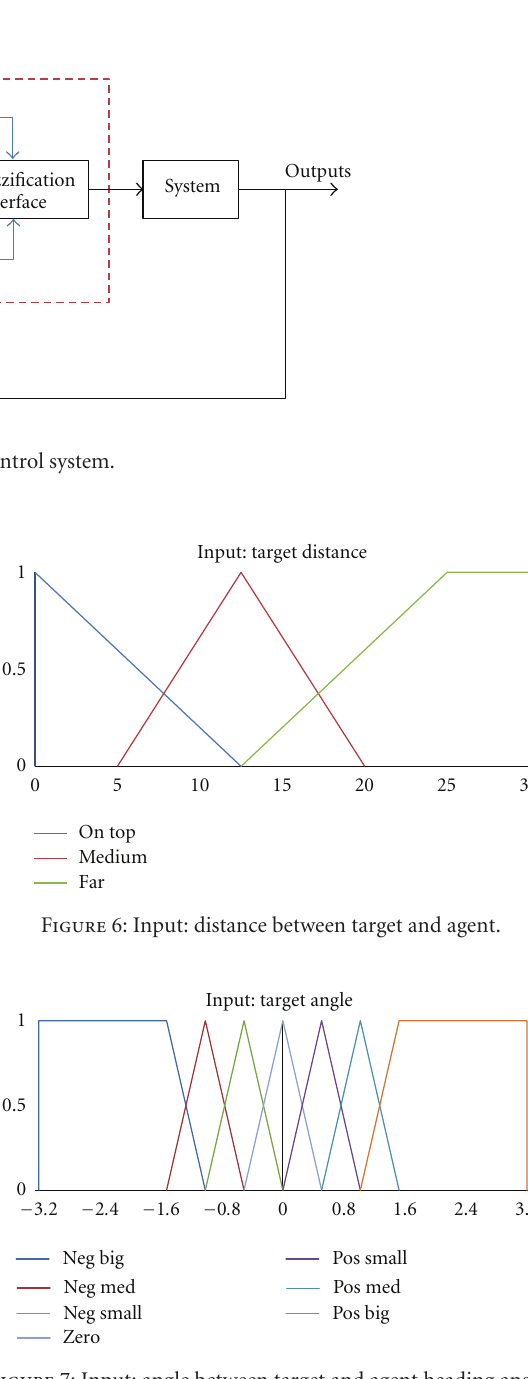
Figure 5: Input: angle between obstacle and agent heading angle.